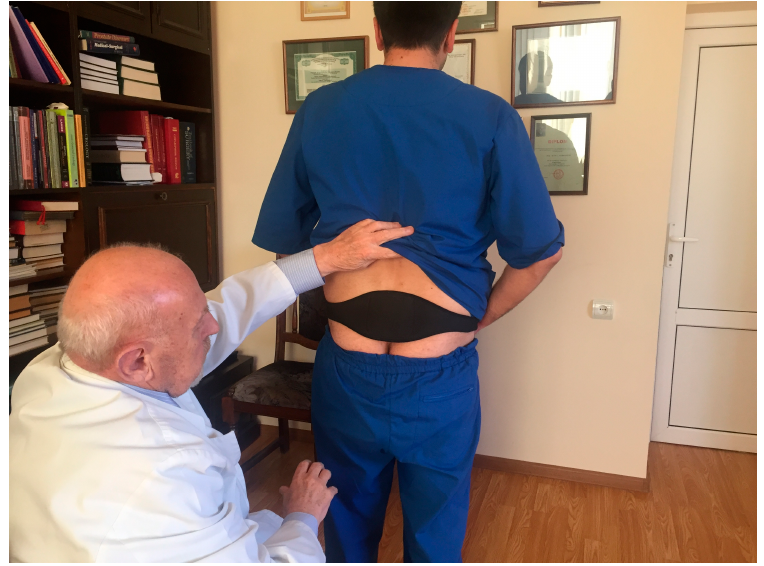
Figure 1. The therapeutic device is placed on the patient’s body.